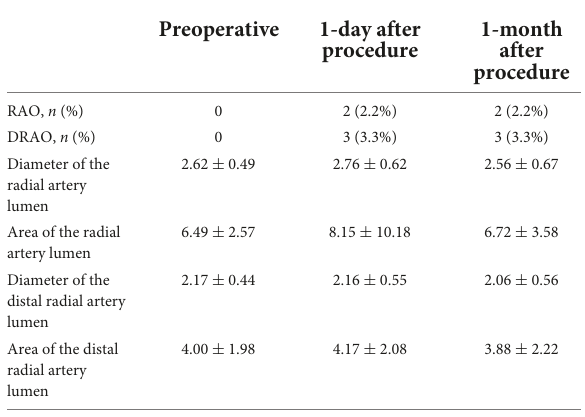
TABLE 4 Vascular ultrasound results before and after dTRA intervention.